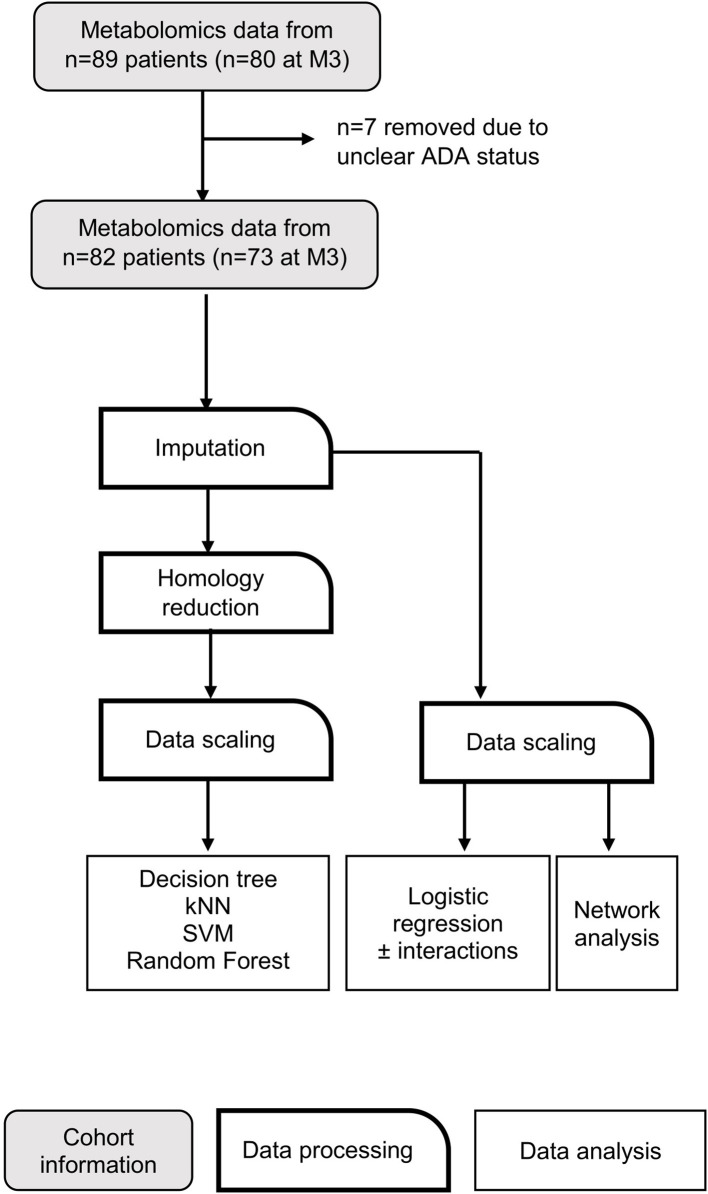
Data analysis workflow. Flow chart depicting data processing steps taken before application of machine learning algorithms. kNN, k nearest neighbors; SVM, support vector machine.